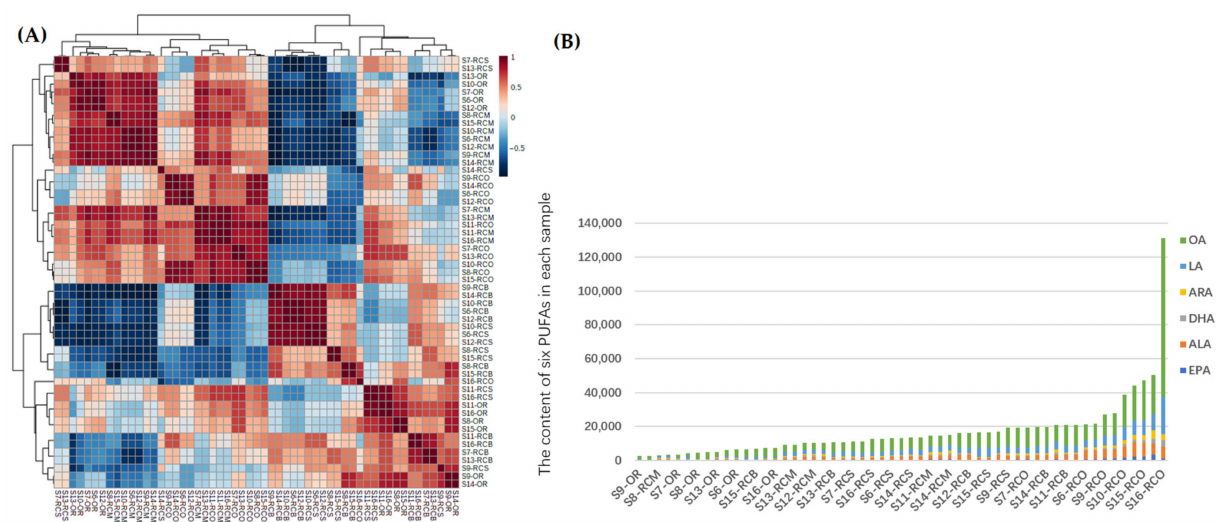
Figure 8. ( A ) Clustering heatmap of six PUFAs in each sample. ( B ) Total content sequence of six PUFAs in each